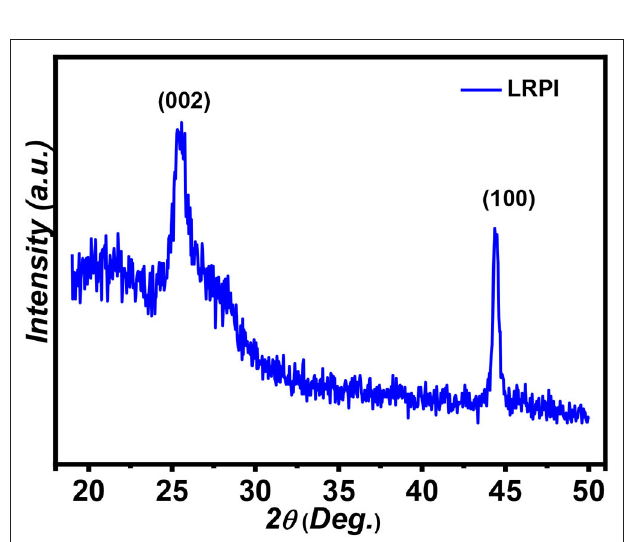
FIGURE 2 | The X-ray diffraction pattern of (LRPI) comprising of reflections from (002) and (100) planes.